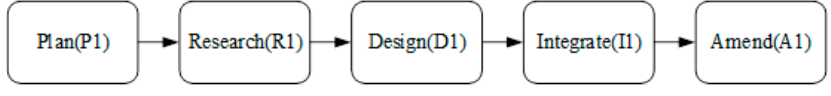
Figure 2. Level 1 of the DCOR model.